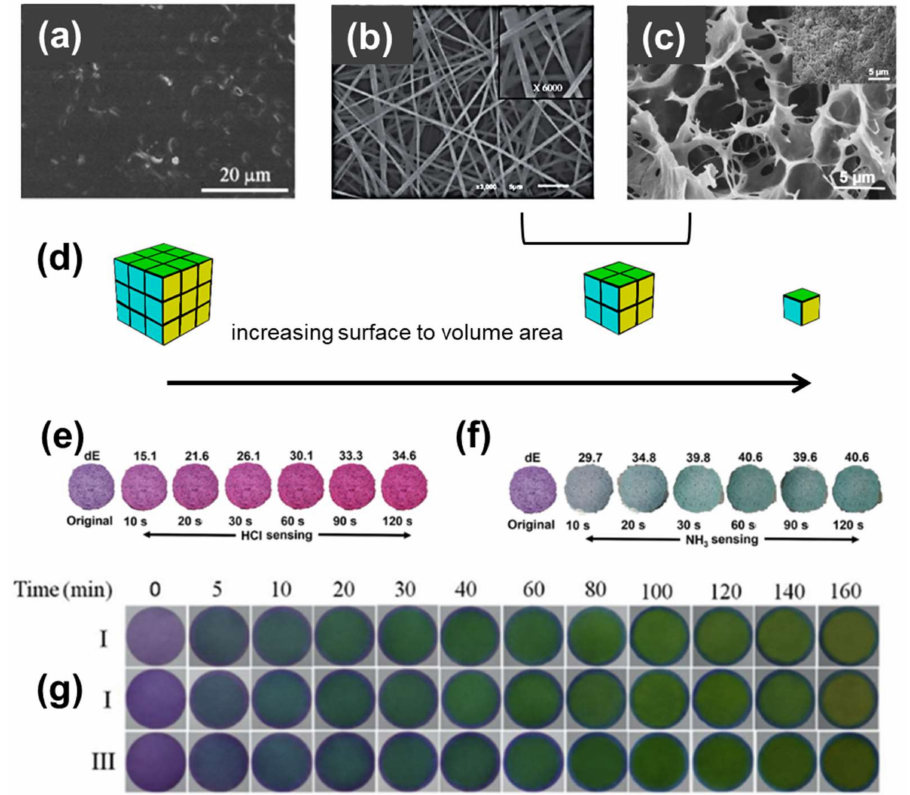
Figure 6. SEM images of ( a ) polyvinyl alcohol/okra mucilage polysaccharide-based film containing rose anthocyanins. Reproduced with permission from Ref. [138], ( b ) zein-based fibers containing red cabbage anthocyanin extract. Reproduced with permission from Ref. [72]. ( c ) PVA/PVP/cellulose- based foams containing red cabbage anthocyanin extract. ( d ) The increasing surface to volume area with the increase in porosity. pH-induced color evolution over time of the ( e ) foams exposed to HCl vapors, ( f ) foams exposed to NH 3 vapors. ( c,d ) Reproduced with permission from Ref. [31]. ( g ) Films exposed to NH 3 vapors. Reproduced with permission from Ref.